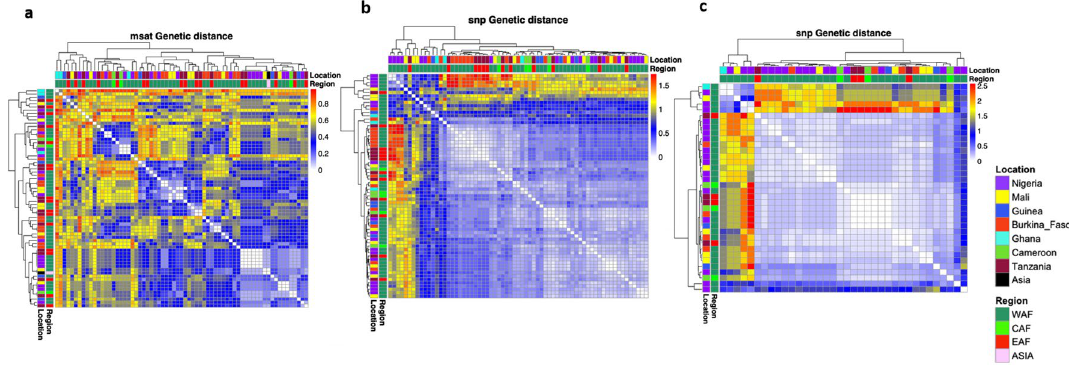
Figure 2. Clustering and heatmap of pairwise genetic distances computed using the pheatmap_1.0.12 package in R Version 4.1.13, ( a ) Bruvo’s distance from microsatellite (Msat) ( b ) Nei’s genetic distance between individual samples from SNPs in candidate drug resistance loci (unfiltered data) and ( c ) Nei’s genetic distance computed from SNPs after denoising and filtration of reads. Each sample’s origin by country or geographic region is shown as side bars at the branch ends of